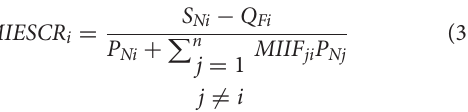
coefficient of the j- th terminal LCC converter; and k is the number of